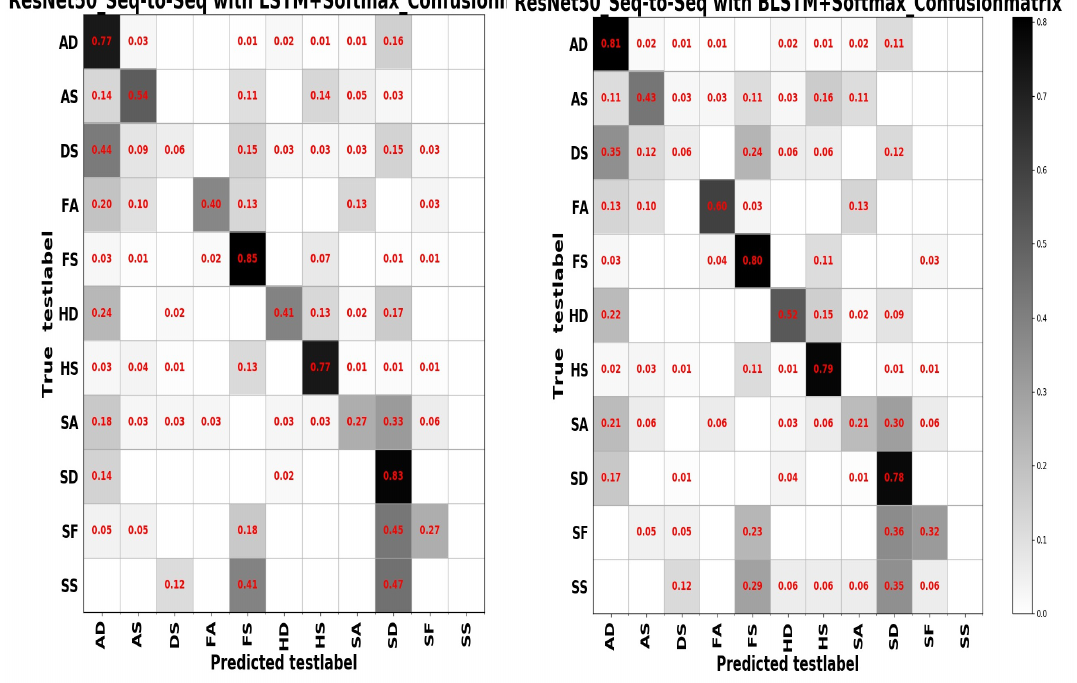
Figure 15. The confusion matrix on the RAF Compound test set for the model ensembling of ResNet50 and Seq-to-Seq with LSTM+Softmax ( left ); the confusion matrix on the RAF Compound test set for the model ensembling of ResNet50 and Seq-to-Seq with BLSTM+Softmax ( right